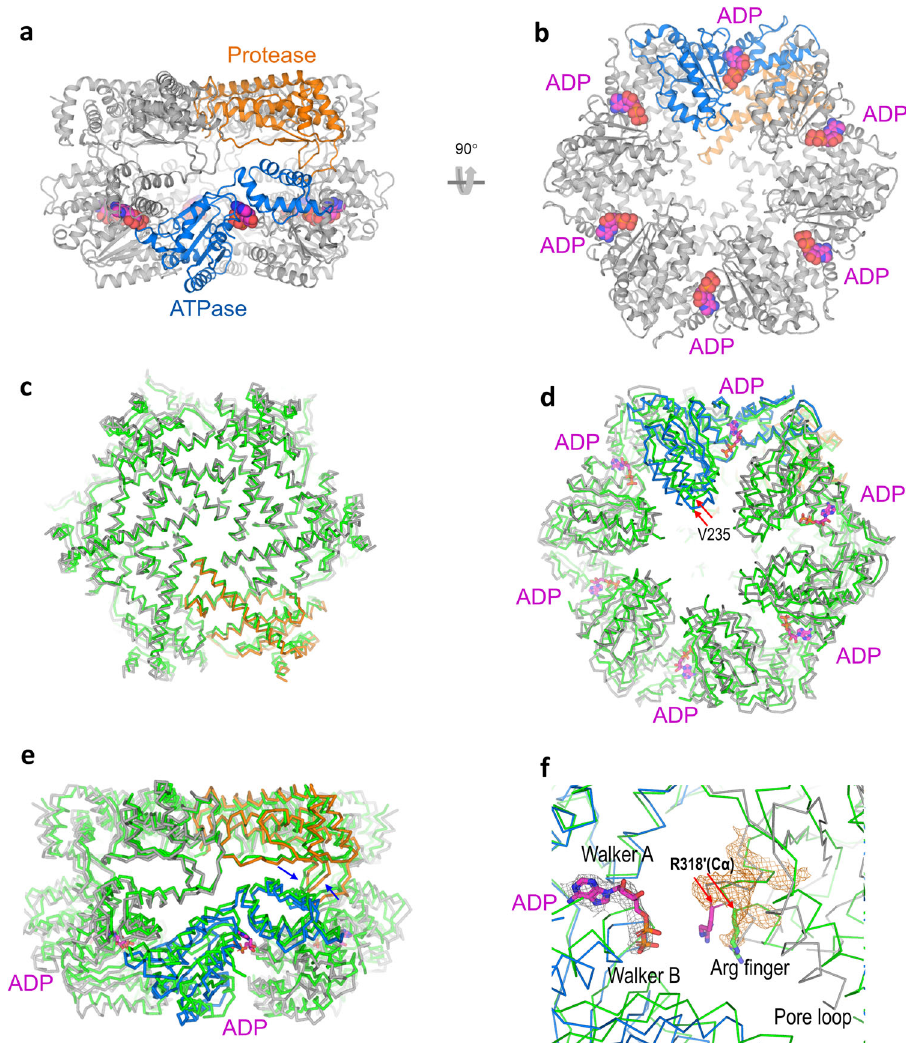
Fig. 3 Tm FtsH structure in a symmetric ADP state. a , b Two views of the overall structure of symmetric protease and ATPases domains. One subunit was colored orange for protease and marine for ATPase, and the rest subunits were colored in gray. ADP molecules are shown as spheres. c – e Three views of the superimposition of the ADP-state structure (colored in the same way as in a and b ) with its apo-state crystal structure (PDB code 3KDS, colored in green). Both structures have a six-fold symmetry. The ADP-state structure was colored as in a , and the apo-state structure was colored in green. ADP molecules are shown as sticks. Red arrows indicate the C α atom positions for measuring the distance between two V235 residues. Blue arrows indicate the loops connecting the protease and ATPase domains. f Superimposition of ADP-state structure and the apo structure for the binding sites as well as their next clockwise neighboring region. Arginine fi nger residue R318 ′ is shown as magenta (ADP-state) and green (apo-state). Red arrows indicated the C α atom positions for measuring distance. Cryo-EM densities for ADP and the R318 ′ regions were colored as gray and orange isomeshes, the best alignment was based on the protease domains (residues 404 – 603) with an RMSD of 2.0 Å for 1128 aligned C α atoms (Fig. 3c). With the alignment, the side view of the two hexamers indicated conformational changes in the ATPase domains start- ing from the linker loops to their protease domains (Fig. 3d, e and Supplementary Fig. 4a). Consequently, the bottom view indicated a shrink of the ATPase pore from the apo to ADP state by a movement of 4.5 Å as measured by the distance between the C α atoms of residue V235 which is located on the tip of a pore loop (Fig. 3d). Compared with the apo-state structure, ADP-binding triggered larger conformational changes for the Walker B region structure than the Walker A region structure (Fig. 3f). In addition, there are structural changes for the arginine fi nger in the next clockwise subunit where residue R318 ′ C α atom ( “ R318 ′ ” denotes next clockwise subunit) moved 3.6 Å closer to the ADP phosphate